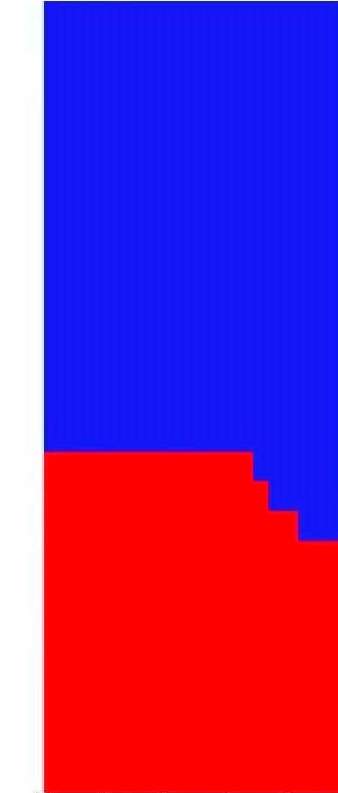
Figure 3. Neighbor-joining tree of the 25 Belgian wheat genotypes and their population structure (at K = 2) based on 1052 DArT markers. The numbers at the nodes of the phylogenetic tree represent the bootstrap values showing the probability of branching at 1000 replications. The red and blue colors represent two different populations.